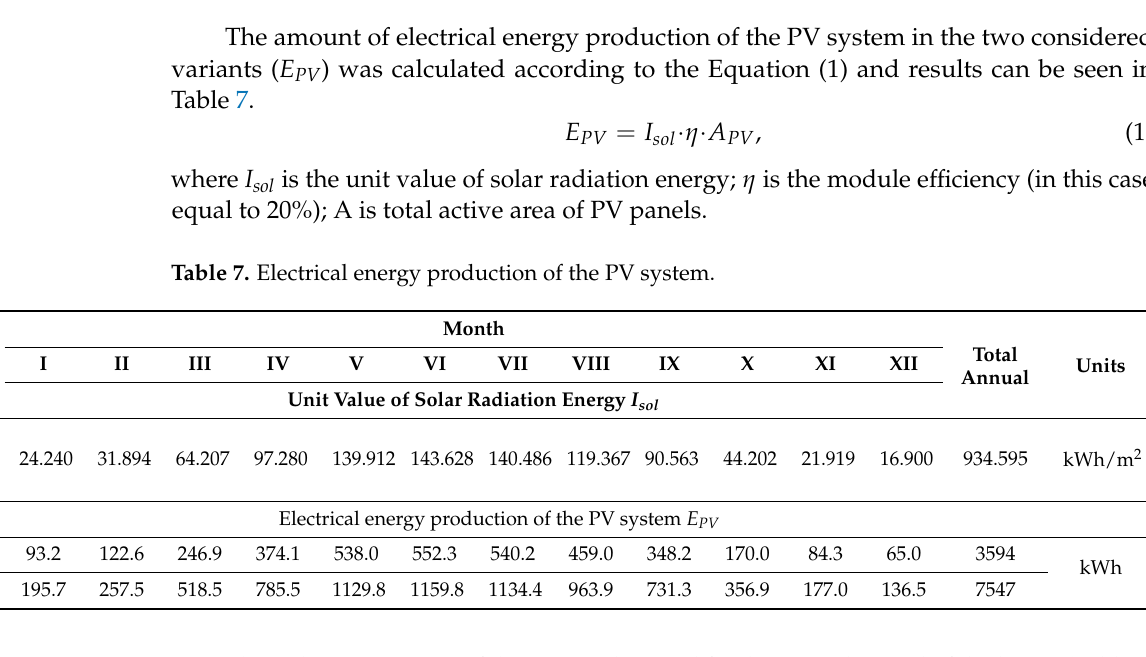
Table 6. The required amount of electrical energy production in analyzed variants. Transmission Required and Off-Take Current Amount of Electrical from the Power Consumption Electrical Energy PV System Grid, with a of Produced Energy Consumption Variant 20% Allowance Energy Production for Its Storage kWh/year Variant I 3059 918 2570 3488 Variant II 6600 1980 5544 7524